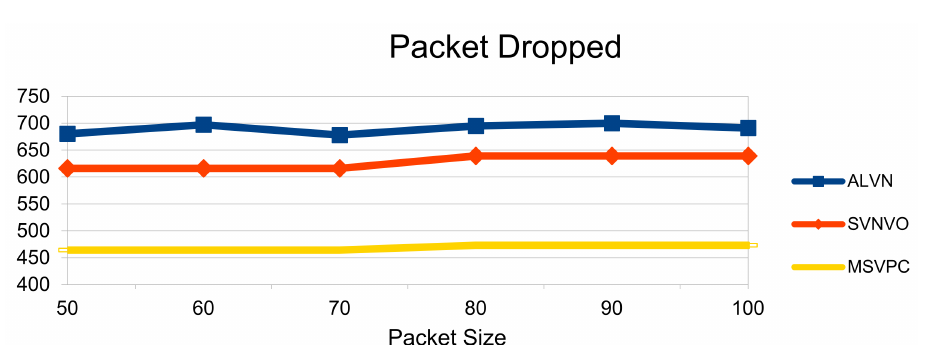
Figure 8. Interval vs. delay.